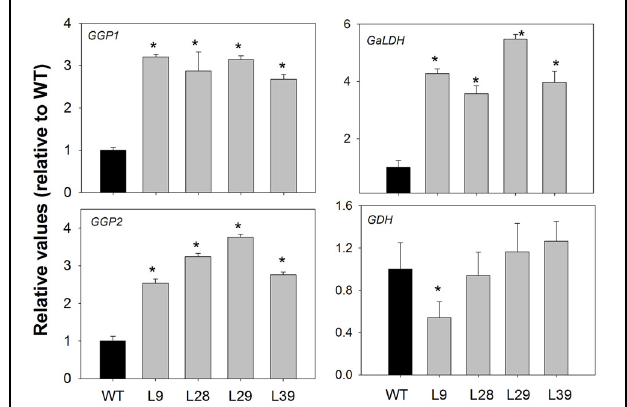
FIGURE 6 | Expression of GGP , GaLDH, and GDH genes in red B33-PPi fruits. The abundance of GGP1(acc. number Solyc06g073320), GGP2 (acc. number Solyc02g091510), GaLDH (acc. number Solyc10g079470), and GDH (acc. number Solyc01g106450) mRNAs were measured by quantitative RT-PCR, respectively. An asterisk indicates the values that were determined by the t -test to be significantly different ( P < 0 . 05) from wild type.